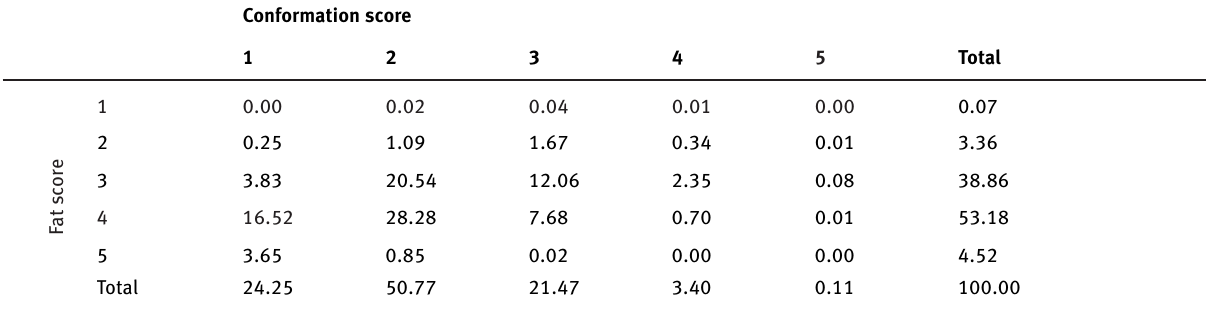
Table 2: Percent of slaughtered lambs in Greenland within each combination of fat and conformation score 1 for 2010-2017 Conformation